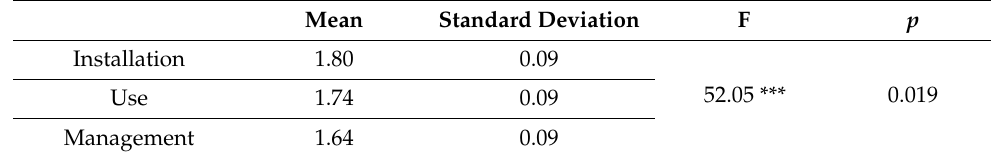
Table 8. Summary of PC Usability of Information Capability. Mean